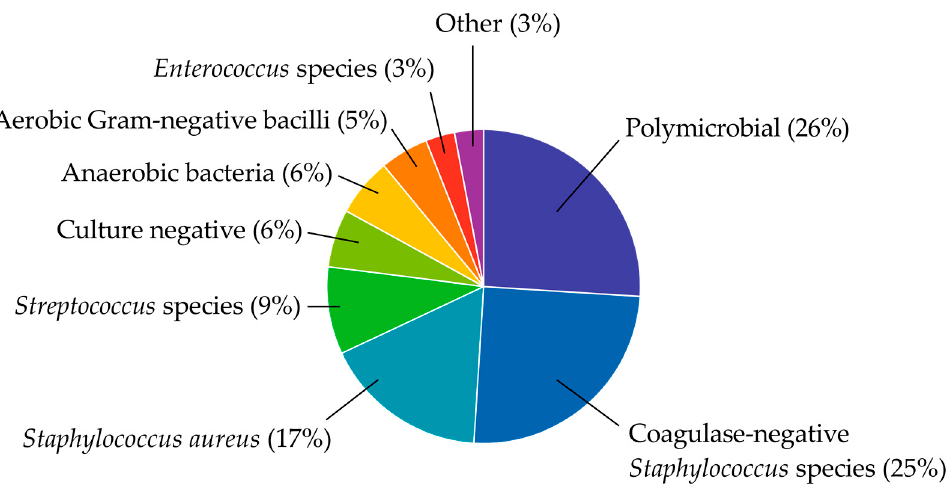
Figure 1. Causes of periprosthetic joint infection after total hip and total knee arthroplasty based on data from Tai, D.B.G. et al. Clin Microbiol Infect 2022 , 28 , 255–259 [50]. Graph created in GraphPad Prism v9.4.0 (San Diego, CA, USA).